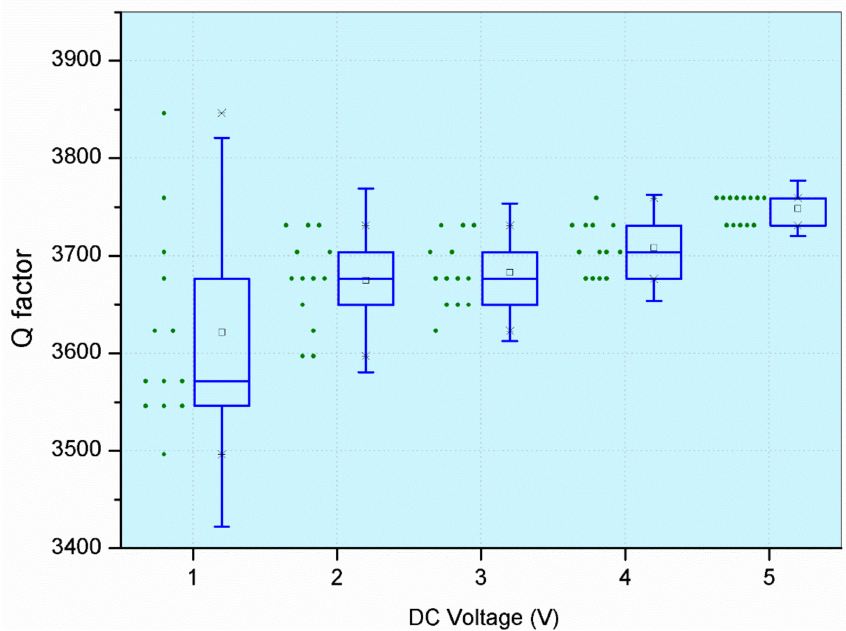
Figure 6. Measurement variations in the Q factor from increasing the DC